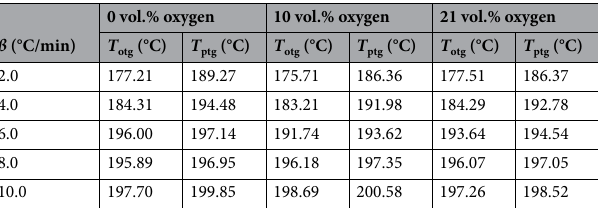
Table 1. Characteristic temperatures of 30 mass% NC-S measured by TG experiment at different β .